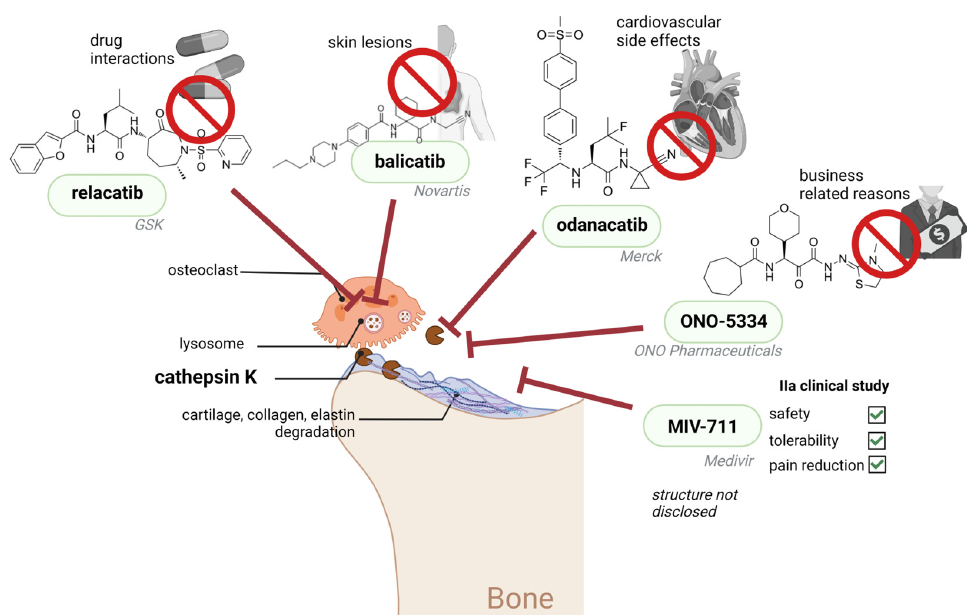
Figure 2. Several cathepsin K inhibitors have entered clinical trials. Lysosomotropic cathepsin K inhibitors relacatib, and balicatib were discontinued due to the unexpected effect on metabolism of commonly used drugs, and side-effect occurrence of morphea-like skin lesions, respectively.